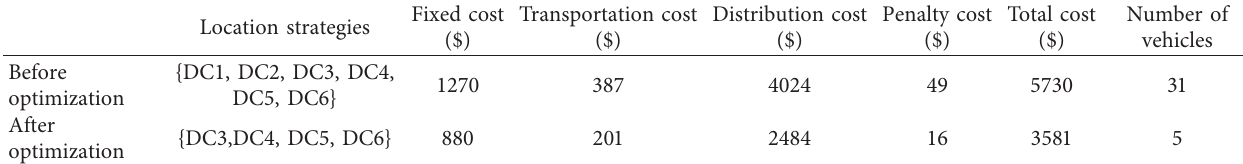
Table 7: Comparison before and after 2E-LRPTWTRS optimization.